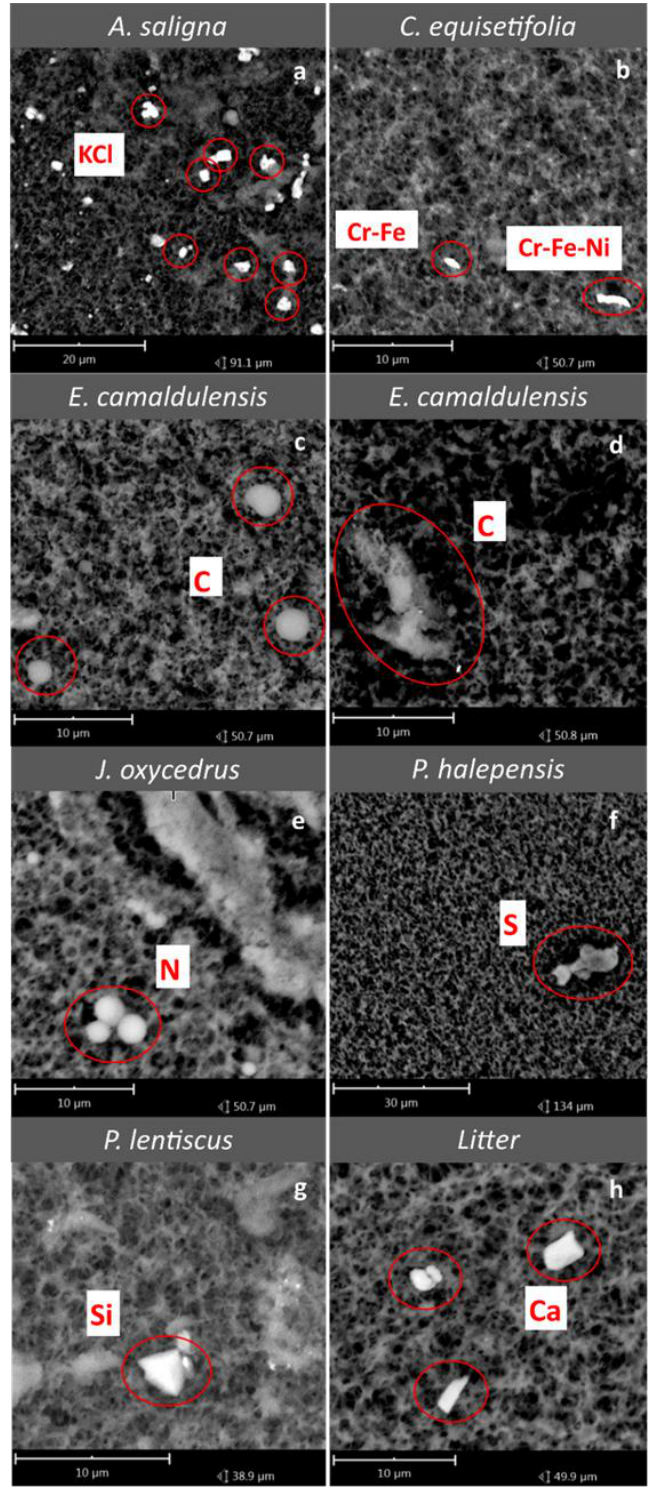
Figure 6. Characteristic SEM images showing the morphology and main elements characterizing the chemical composition of the seven categories identified in relation to species and litter: ( a ) Potassium chloride particles in A. saligna ; ( b ) Iron and steel-based particles in C. equisetifolia ; ( c ) Carbon-based spherical particles for E. camaldulensis ; ( d ) Carbon-based soot agglomerates for E. camaldulensis ; ( e ) Nitrogen-based particles for J. oxycedrus ; ( f ) rich in Sulphur particle for P. halepensis ; ( g ) Silicon-based particle for P. halepensis and ( h ) rich in Calcium particles for litter.